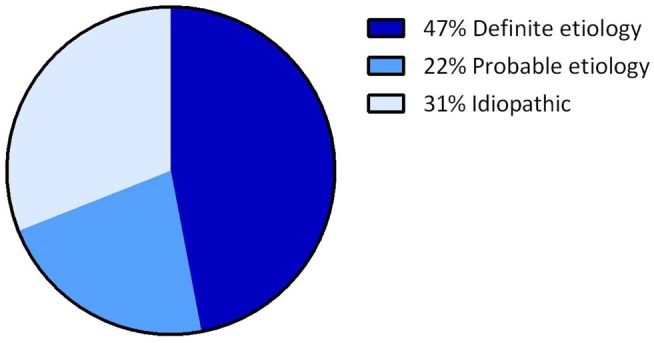
Distribution of certainty of etiology. A definite etiology was found in 47% of the BVH patients, a probable etiology in 22% of the BVH patients and in 31% the etiology of BVH remained idiopathic.